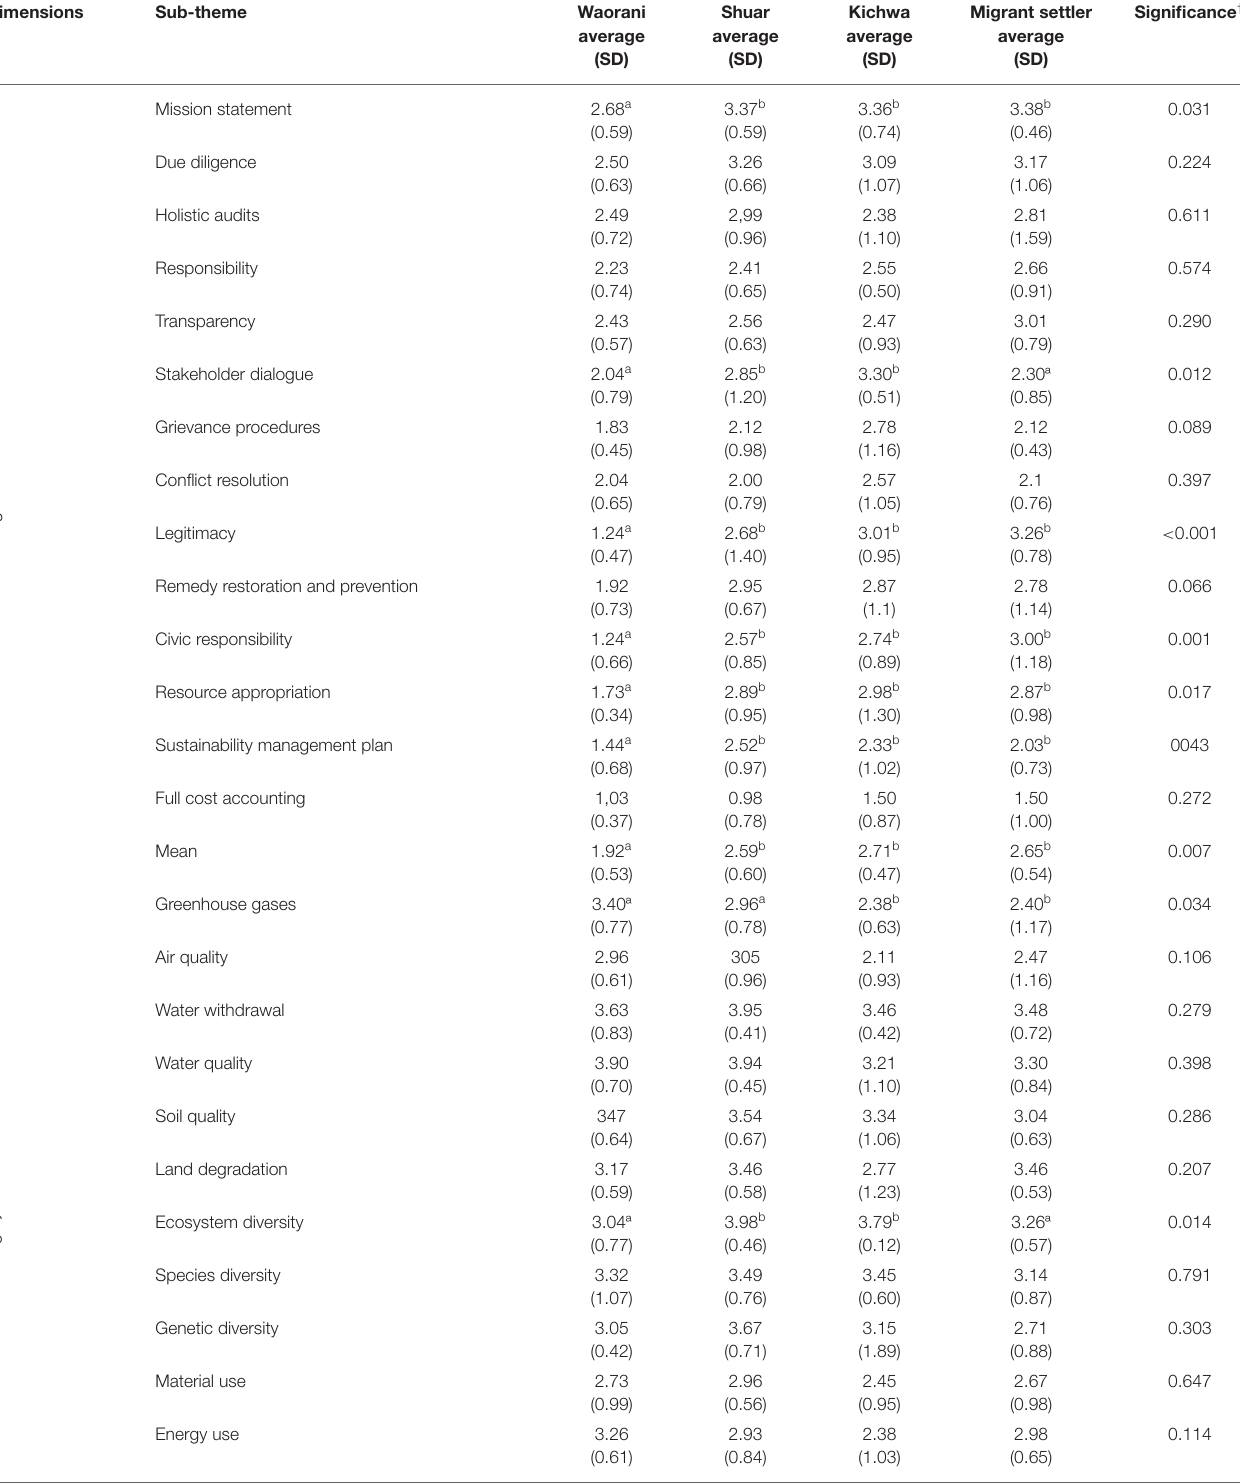
TABLE 6 | Sub-themes evaluated in the four traditional production systems evaluated by social groups in the Yasuní Biosphere Reserve’s Diversity and Life Zone, Amazon region of Ecuador.